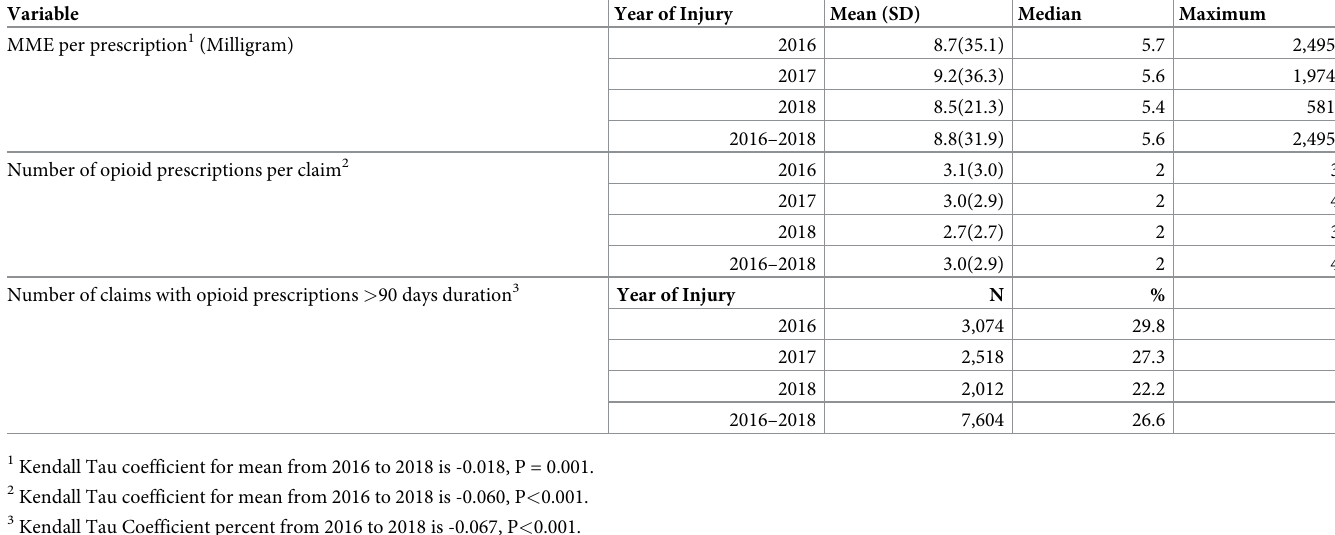
Table 1. Description of morphine milligram equivalents (MME), number of opioid prescriptions per claim and number of claims with opioid prescriptions > 90 days duration within 6-months of an injury among workers, who received a paid wage replacement WC claim, by year from 2016–2018 (n = 28,607 claims).